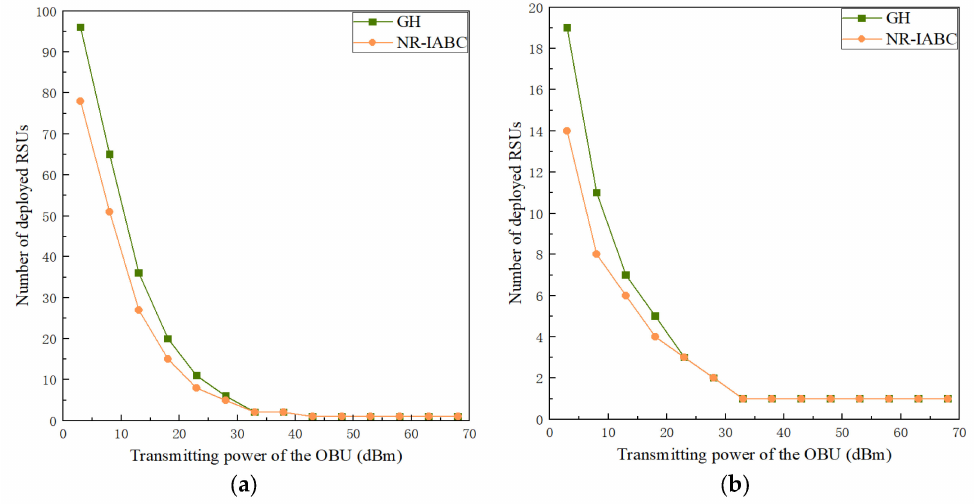
Figure 7. The impact of different transmit power under two conditions: ( a ) b 0 = 3, γ = 0.1; ( b ) b 0 = 3.5, γ =